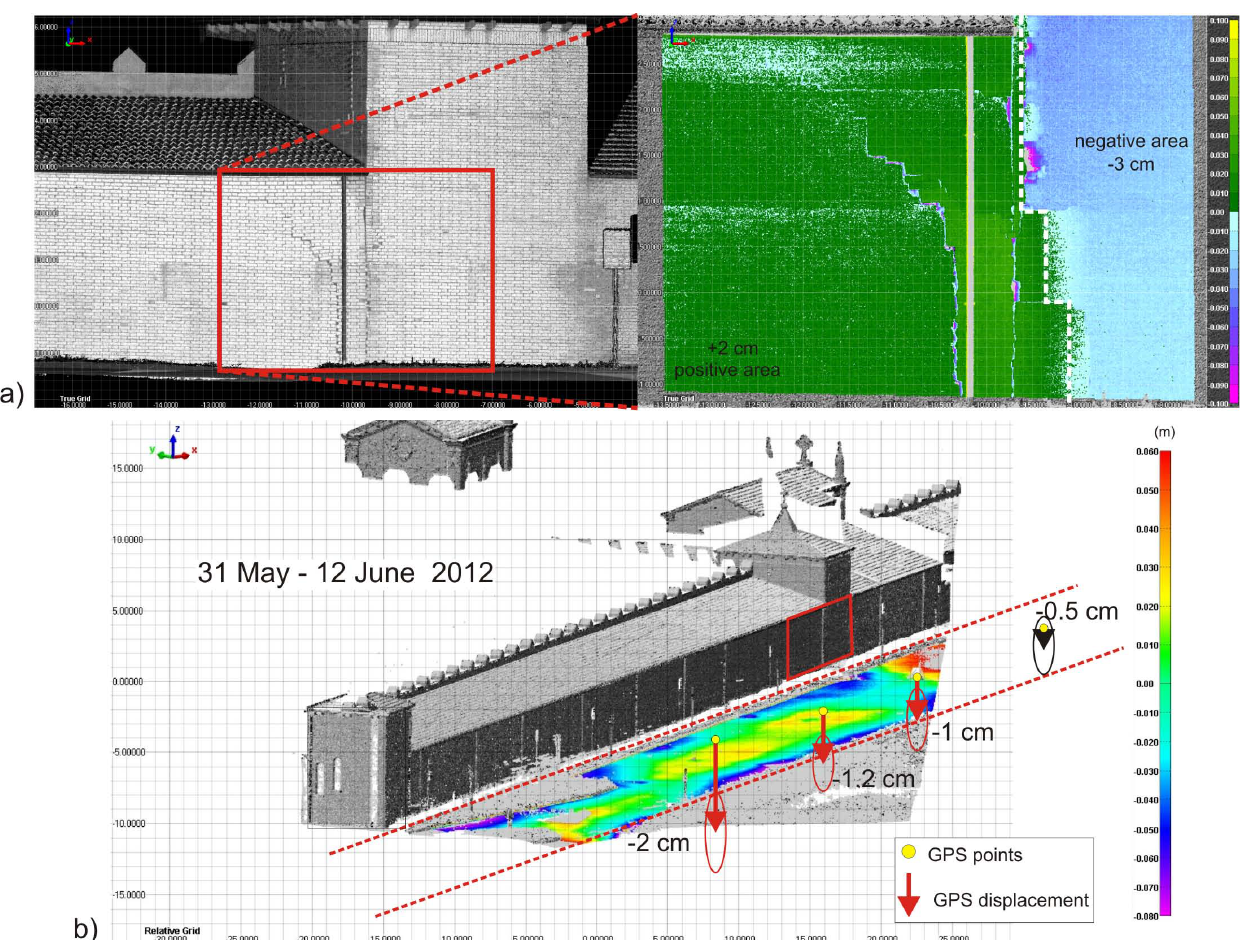
Fig. 6. (a) San Carlo cemetery wall deformation map across the fracture obtained through terrestrial laser scanning (TLS); (b) San Carlo cemetery surrounding street monitored by means of TLS and GPS integration, surveyed from 31 May to 12 June 2012 (terrain lowering: GPS